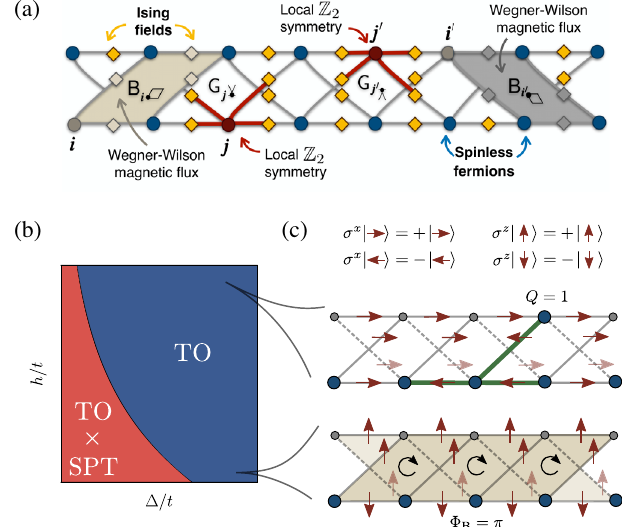
FIG. 1. Creutz-Ising ladder. (a) Spinless fermions, which reside on the sites of a two-leg ladder (filled circles) and can tunnel along and across the legs forming a cross-linked pattern. These tunnelings are minimally dressed by Ising spin- 1 = 2 fields, which sit on the corresponding links (filled rhombi). We represent the Wegner-Wilson fluxes across the two minimal plaquettes (tilted trapezes in grey) and the generators of the local Z 2 symmetries (red graphs). (b) Sketch of the phase diagram at half filling in terms of the electric field h and the imbalance Δ . We find two phases, both with topological order (TO). In one case, the latter coexists with a SPT in the matter sector. (c) For Δ ≫ t , the fermions populate the lower leg of the ladder. At h ≪ t , the Ising fields rearrange to spontaneously generate a π flux per plaquette through an Aharonov-Bohm instability, giving rise to TO. For h ≫ t , the latter survives due to a gauge frustration mecha- nism. Fermions delocalize by forming bound quasiparticles with topological defects created in an otherwise dimerized electric- field